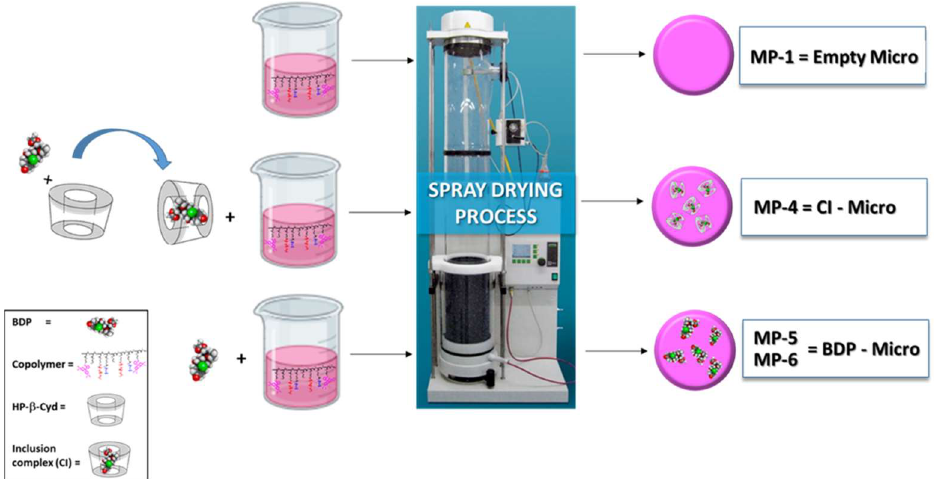
Figure 1. Schematic representation of empty and CI- or BDP-loaded MP sample production.